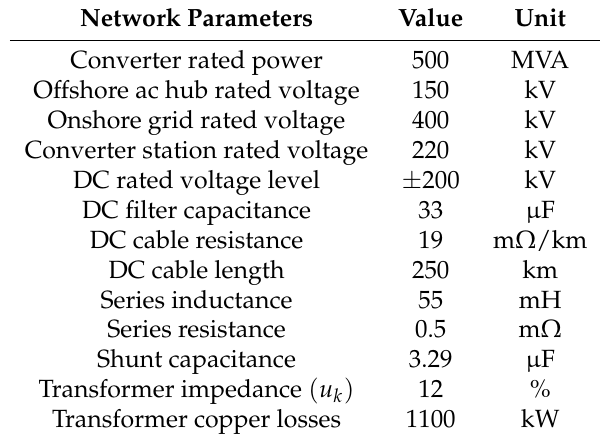
Table 1. Voltage source converter based high voltage direct current transmission system parameters.